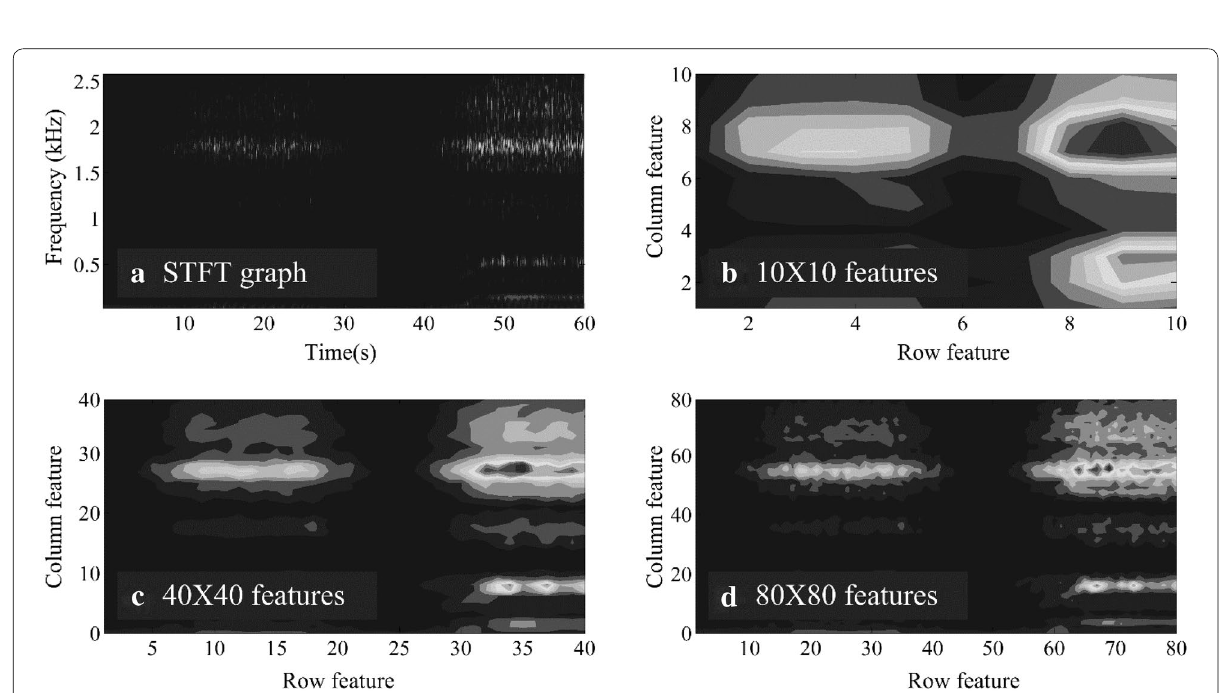
Figure 5 An example of extracted features in the chipped gear: a the STFT graph; b 10